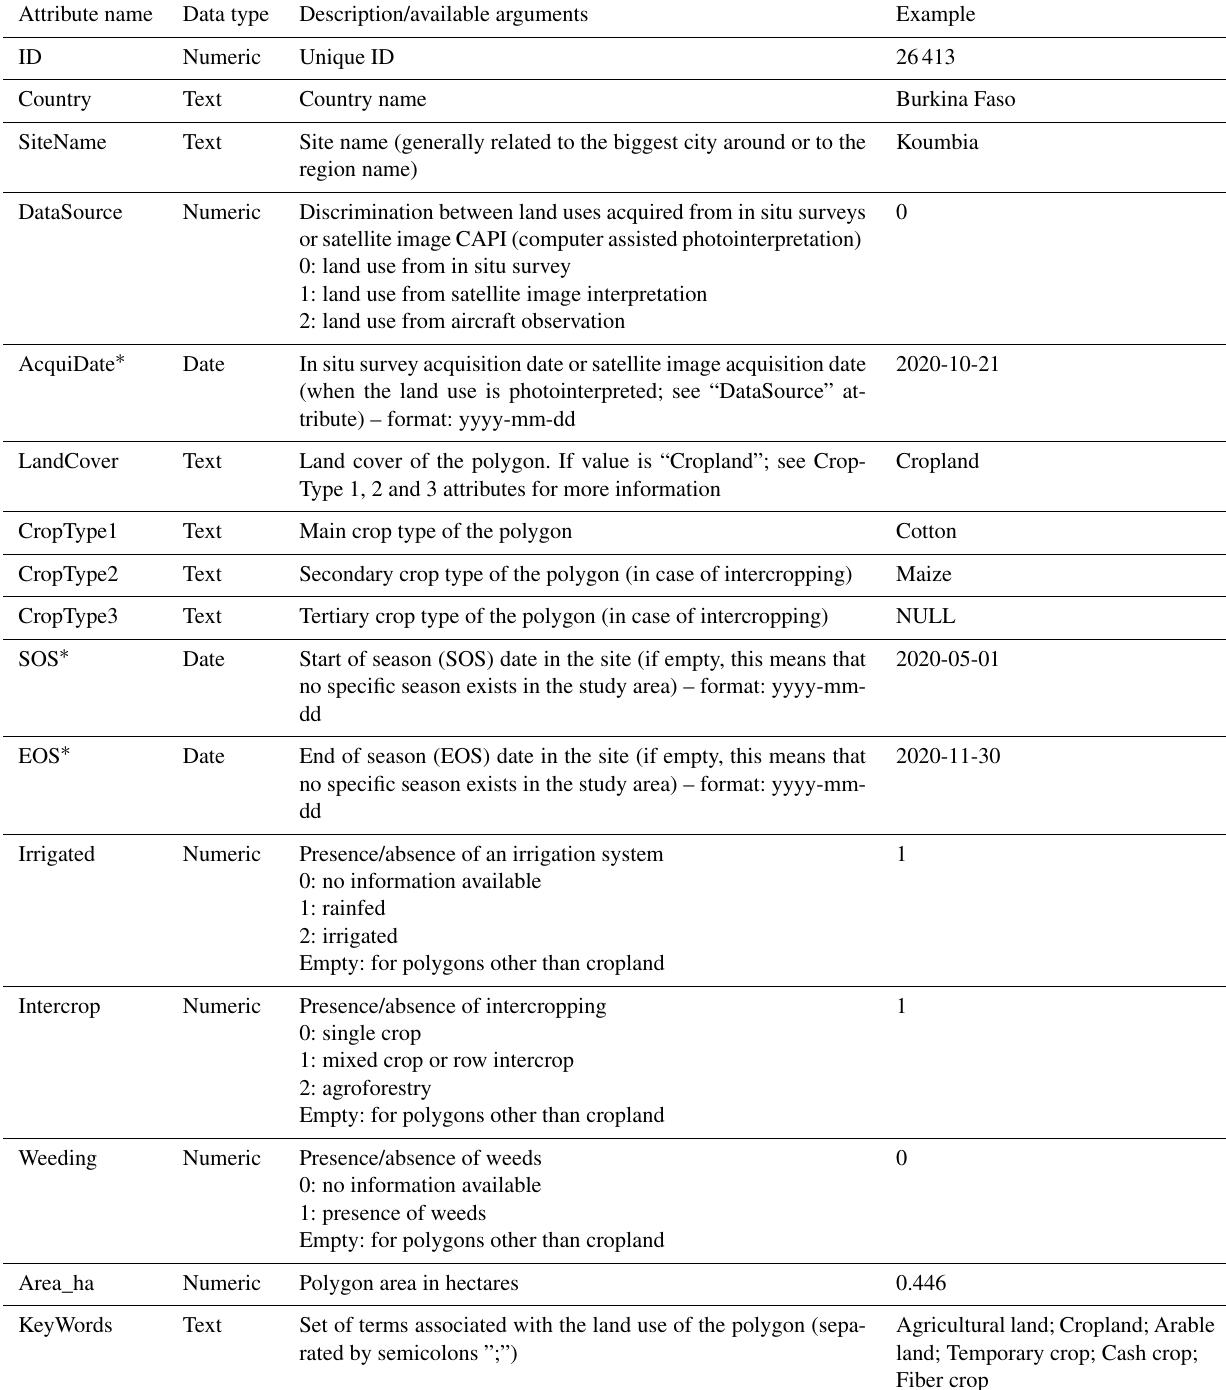
Table 1. Description of the attributes recorded for each polygon of the